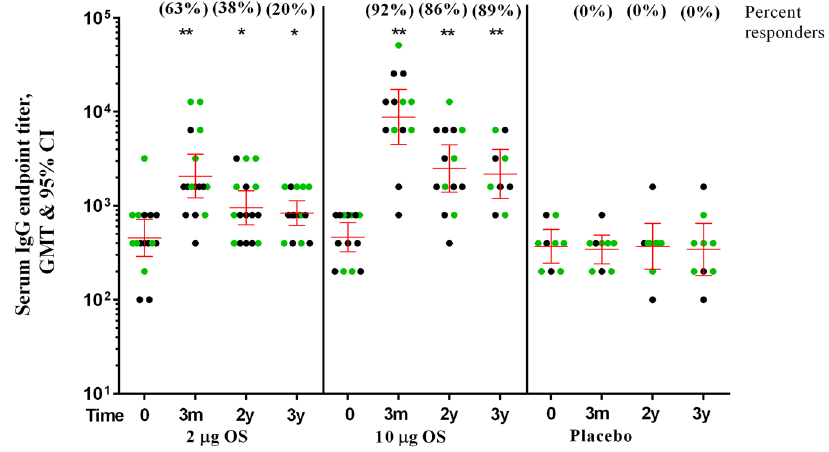
Fig. 1 Longevity of serum IgG GMT (95% CI) to SF2a LPS in vaccinees receiving 2 or 10 µg OS doses of non-adjuvanted and adjuvanted SF2a-TT15 and in placebo recipients. Circles represent individual endpoint titres, green circles represent volunteers receiving the adjuvanted vaccine or placebo. Bars represent the Geometric Mean Titer (GMT) and the 95% Con fi dence Intervals (CIs) on day 0 (baseline), at 3 months, 2 and 3 years post-last vaccination. * p -value < 0.05; ** p -value < 0.01 (vs. day